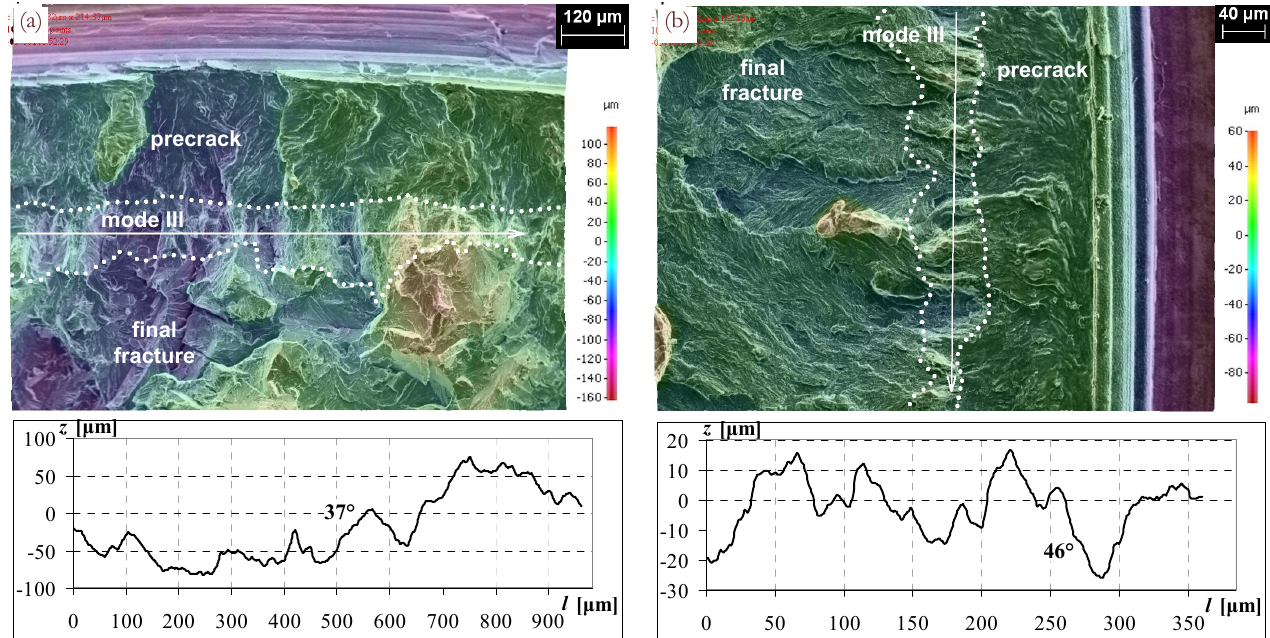
Figure 5: Mode III in pearlitic steel, cylindrical shear specimen (a), torsion specimen (b). The white arrow defines the profile showed below and is parallel to the applied shear